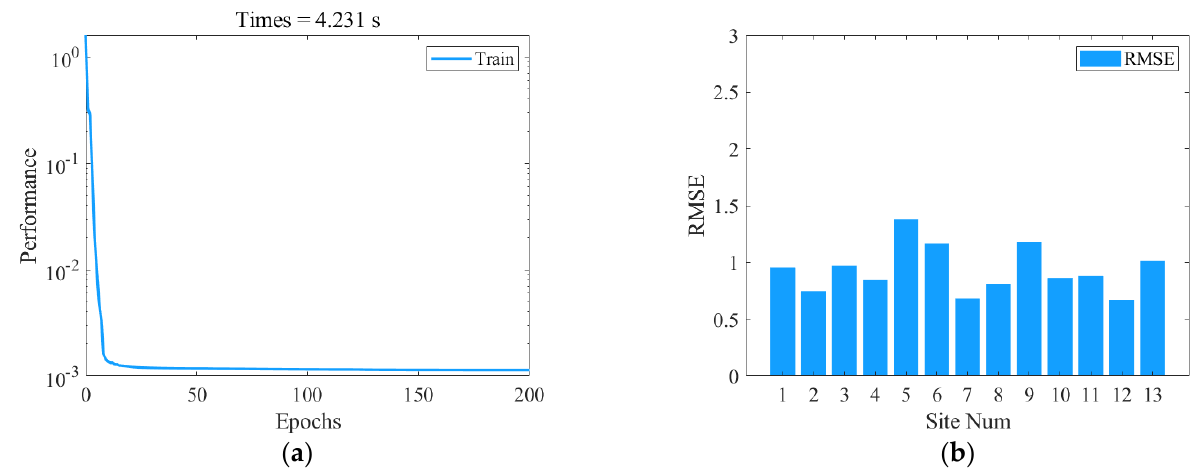
Figure 15. Performance statistic of optimized BP network: ( a ) predicted RMSE at 13 sites; and ( b ) performance curve of the optimized BP network.